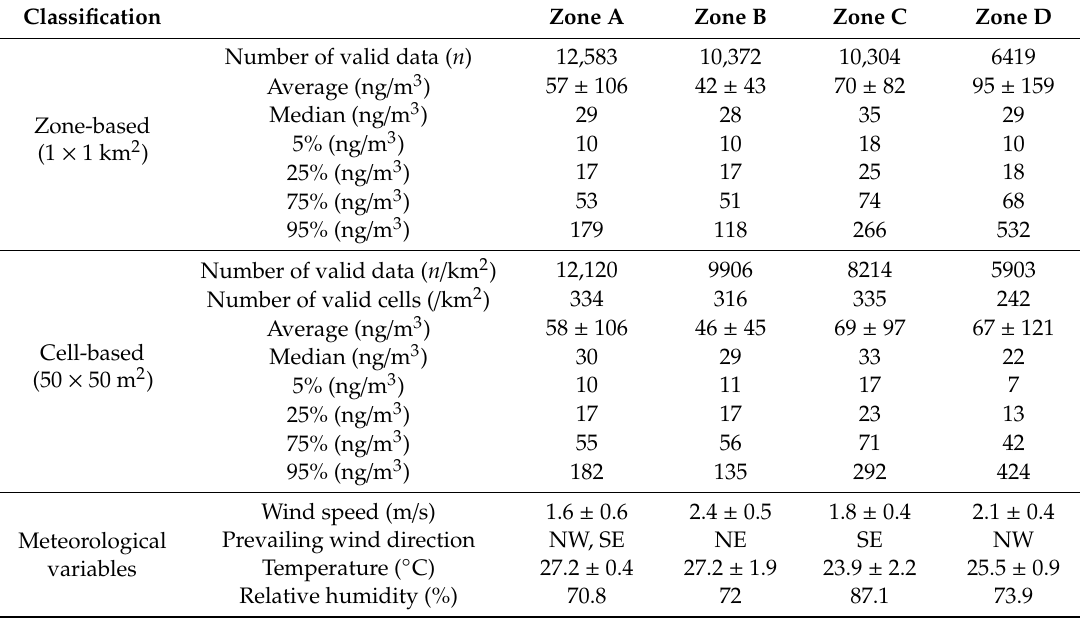
Table 3. Zone- and cell-based statistical analysis of pPAH concentrations over a 2 × 2 km 2